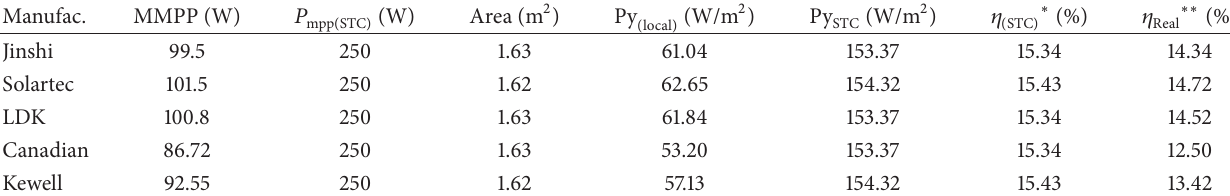
Table 4: Py and 𝜂 for 5 PV panels at Merida city.